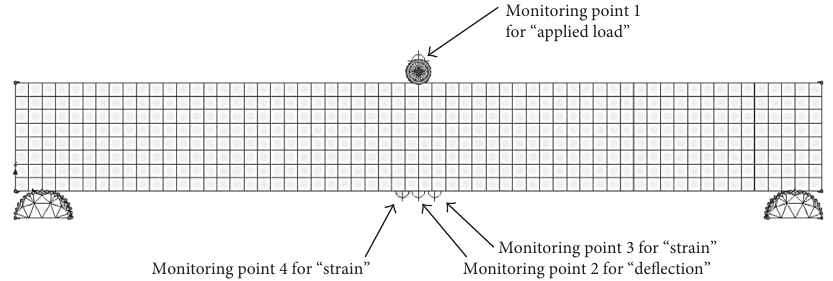
Figure 6: Finite element meshes and monitoring point definition.